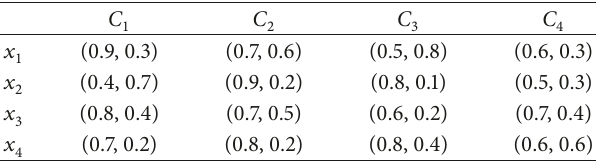
Table 1: Pythagorean fuzzy decision